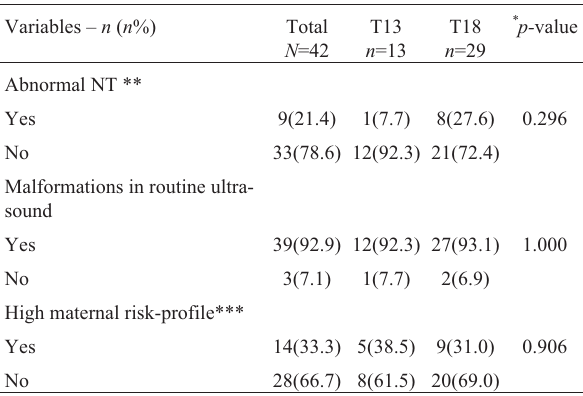
Table 2 - Referral reasons for specialized follow-up of high risk-profile pregnancies.